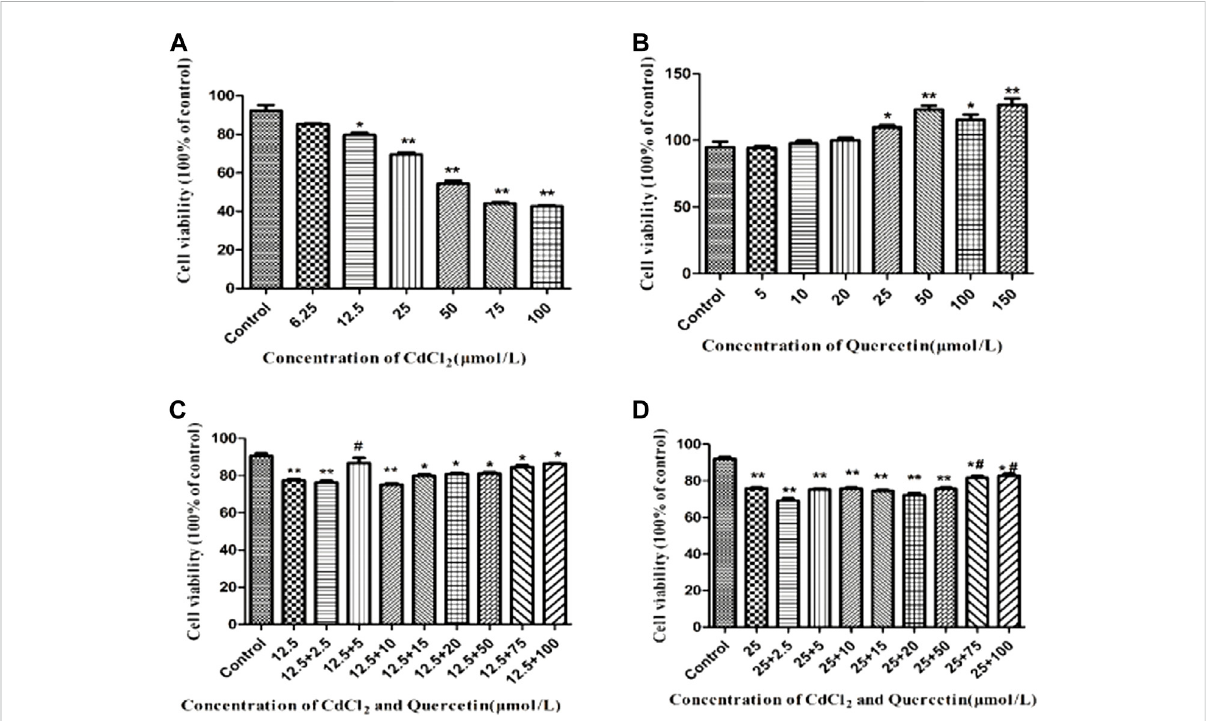
FIGURE 1 Detection of cell viability by MTT assay. The data are expressed in the form of (mean ± SEM), “ * ” indicates signi fi cant difference compared with the control group ( p < 0.05), “ ** ” indicates extremely signi fi cant difference compared with the control group ( p < 0.01), “ # ” indicates signi fi cant difference compared with the 12.5 μ mol/L CdCl 2 group or the 25 μ mol/L CdCl 2 group ( p < 0.05), “ ## ” indicates extremely signi fi cant difference compared with the 12.5 μ mol/L CdCl 2 group or the 25 μ mol/L CdCl 2 group ( p < 0.01).